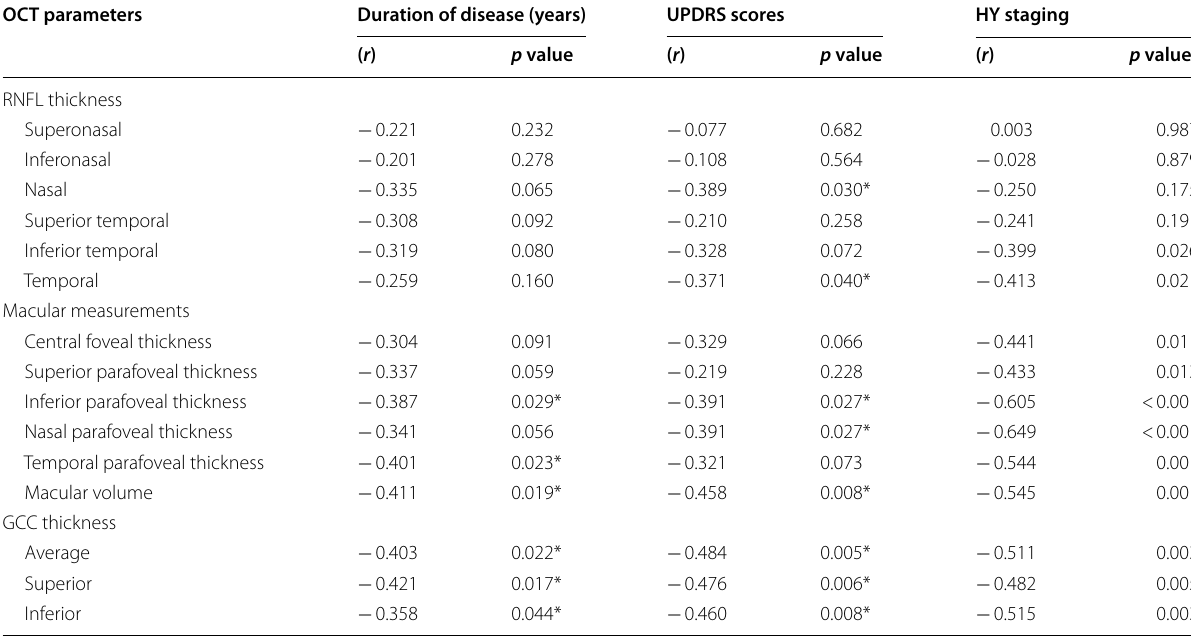
Table 3 Correlations between the duration of the disease, the total UPDRS score, HY staging and OCT